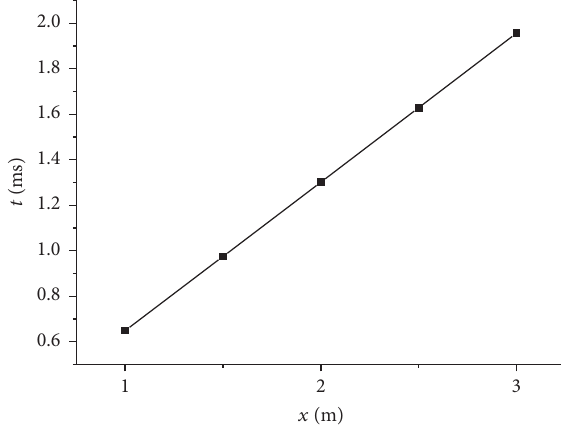
Figure 10: Transfer time- (𝑡 - ) distance ( x ) curve for the incident shock wave when 𝑃 𝑤 = 1MPa and 𝑈 𝑚 = 9